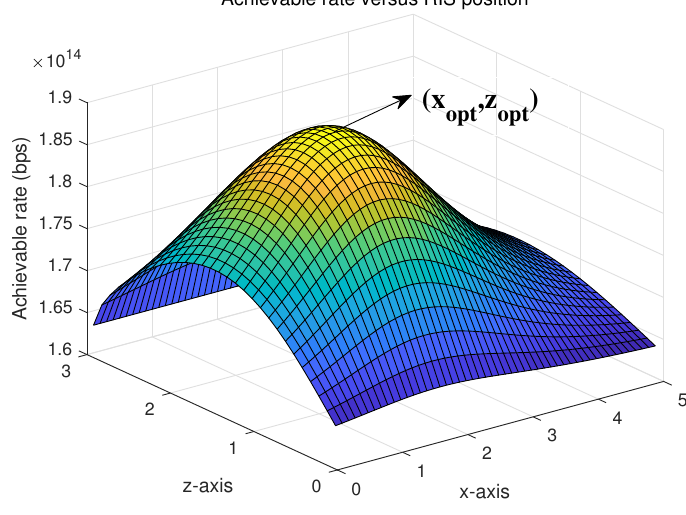
Figure 4. Achievable rate versus RIS